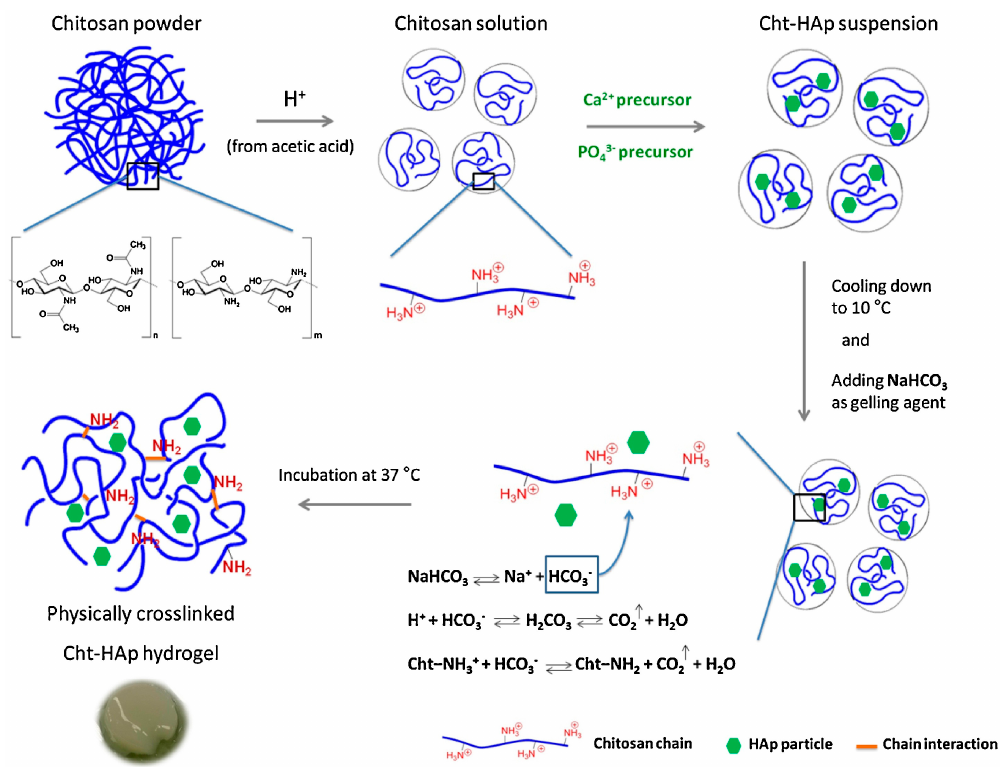
Figure 2. Preparation of a physically crosslinkinked injectable hydrogel based on chitosan and hydroxyapatite. Reproduced with permission from [87], copyright 2017 Elsevier.